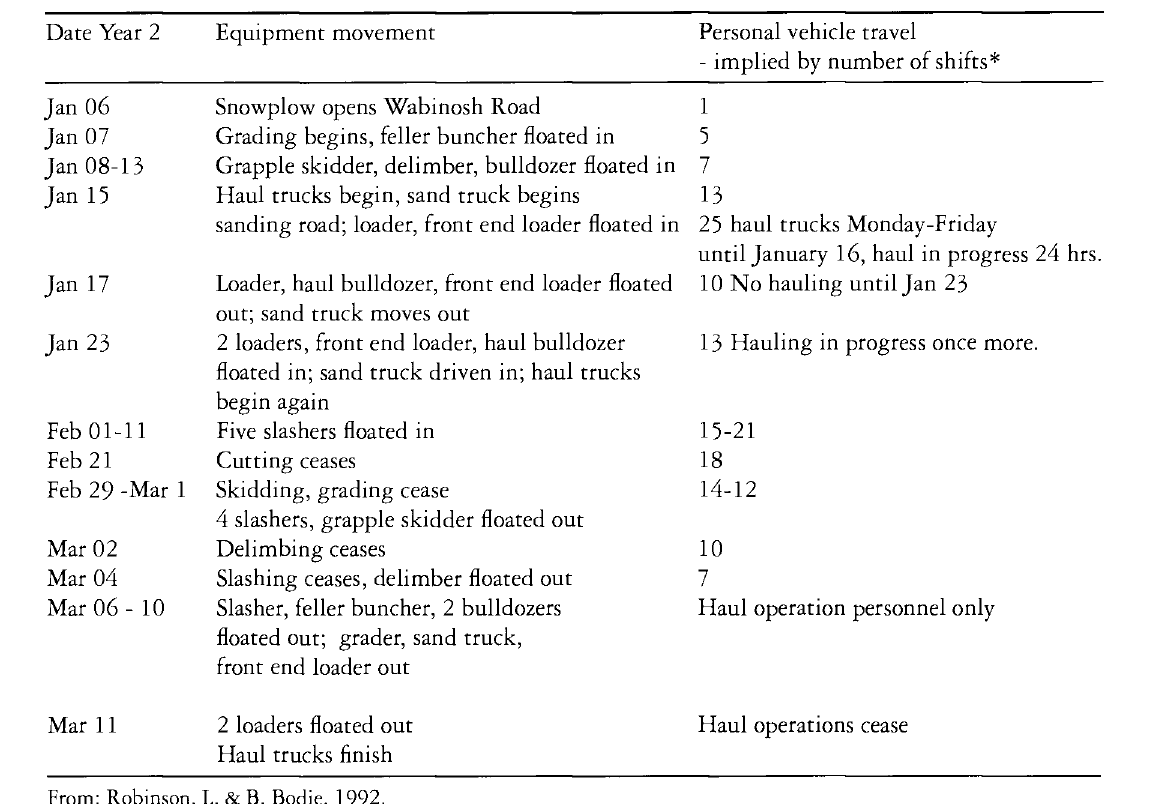
Table 2. Chronological time chart of traffic on haul road during